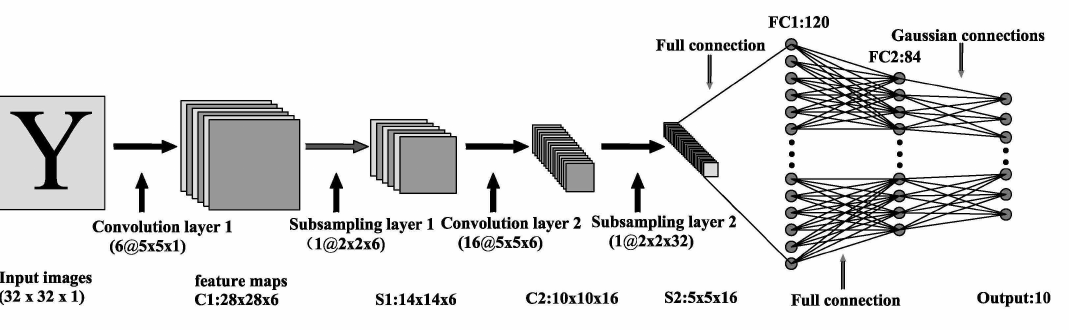
Figure 6. The LetNet–5 structure.